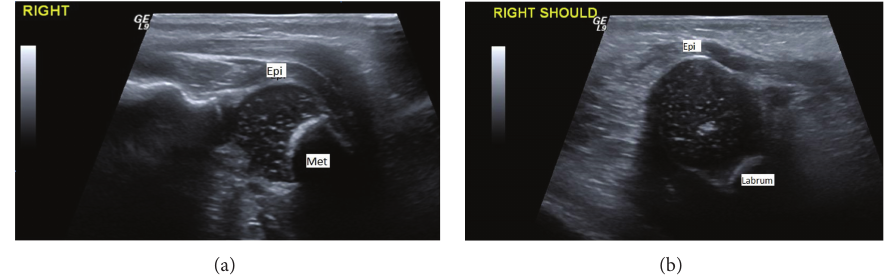
Figure 2: (a) Longitudinal sonogram of the right shoulder demonstrates the normal relationship of the epiphysis (epi) on the metaphysic (met). (b) Transverse sonogram of the right shoulder demonstrated the right humeral epiphysis within the right glenoid